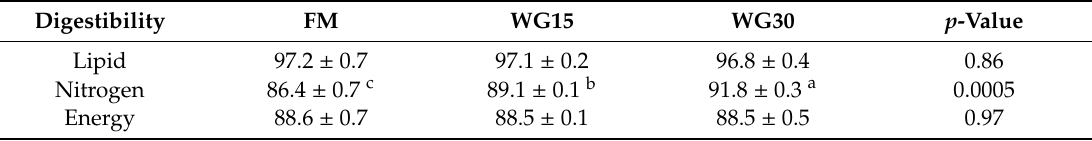
Table 3. Apparent digestibility coe ffi cients (ADC) for lipid, nitrogen, and energy in salmon fed with FM or WG-containing diets. Data are mean ± S.E.M.; n = 3 replicate tanks. Significant di ff erences ( p < 0.05) between the dietary groups are indicated with di ff erent letters.